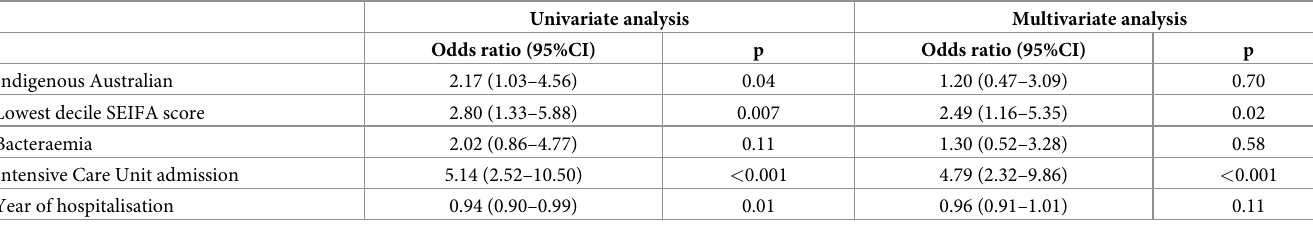
Table 6. Multivariate analysis to identify factors independently associated with